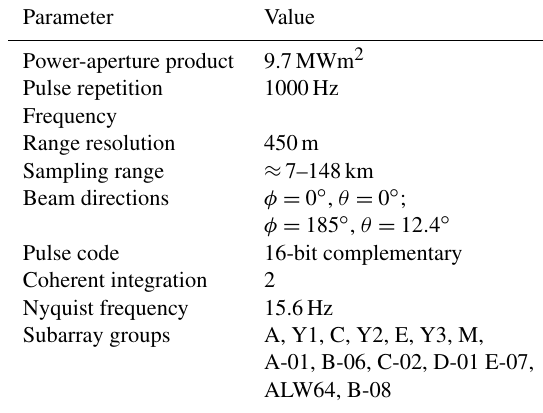
Table 1. Details of the monitoring experiment mst006 also used to observe meteor head echoes, accompanied by the list of used subarray groups (see Fig. 1 for comparison). The antennae Y1, Y2, Y3 and ALW64 are external antennae and are not used in this